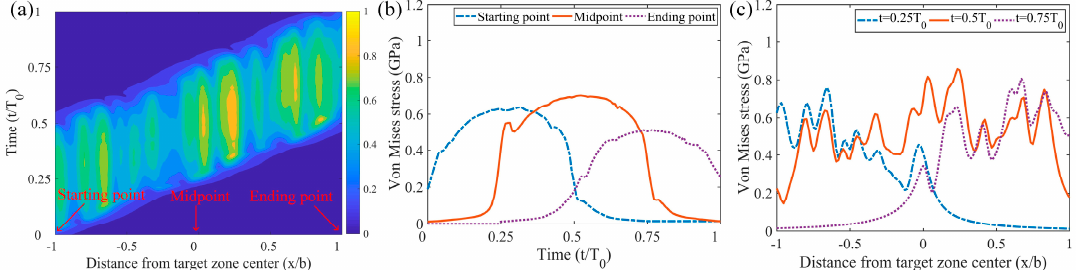
Figure 8. Stress history during a pure rolling contact, ( a ) von Mises stress distribution, ( b ) stress-time plots, ( c ) stress-position plots.